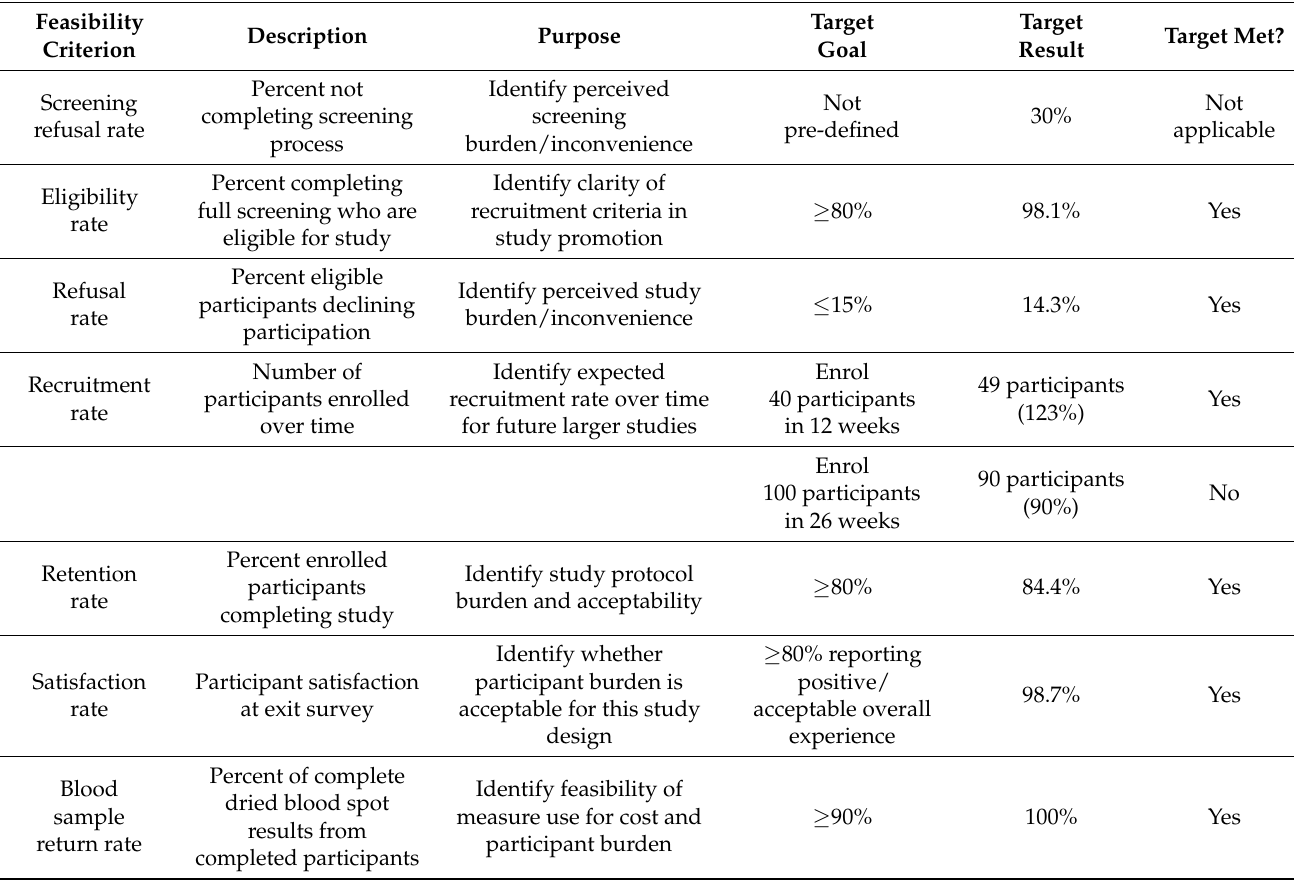
Table 2. Process-related feasibility